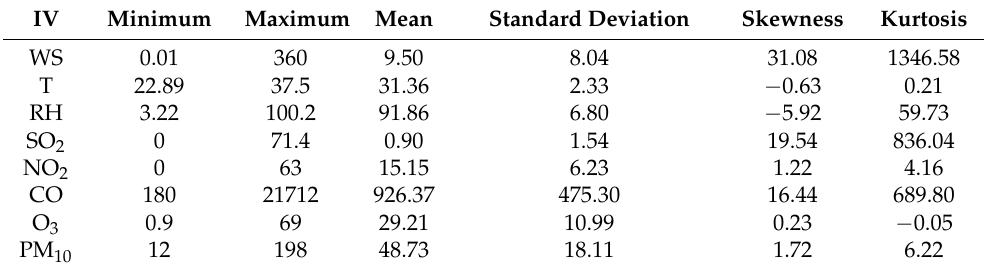
Table 3. The descriptive statistics of independent variables (IVs).